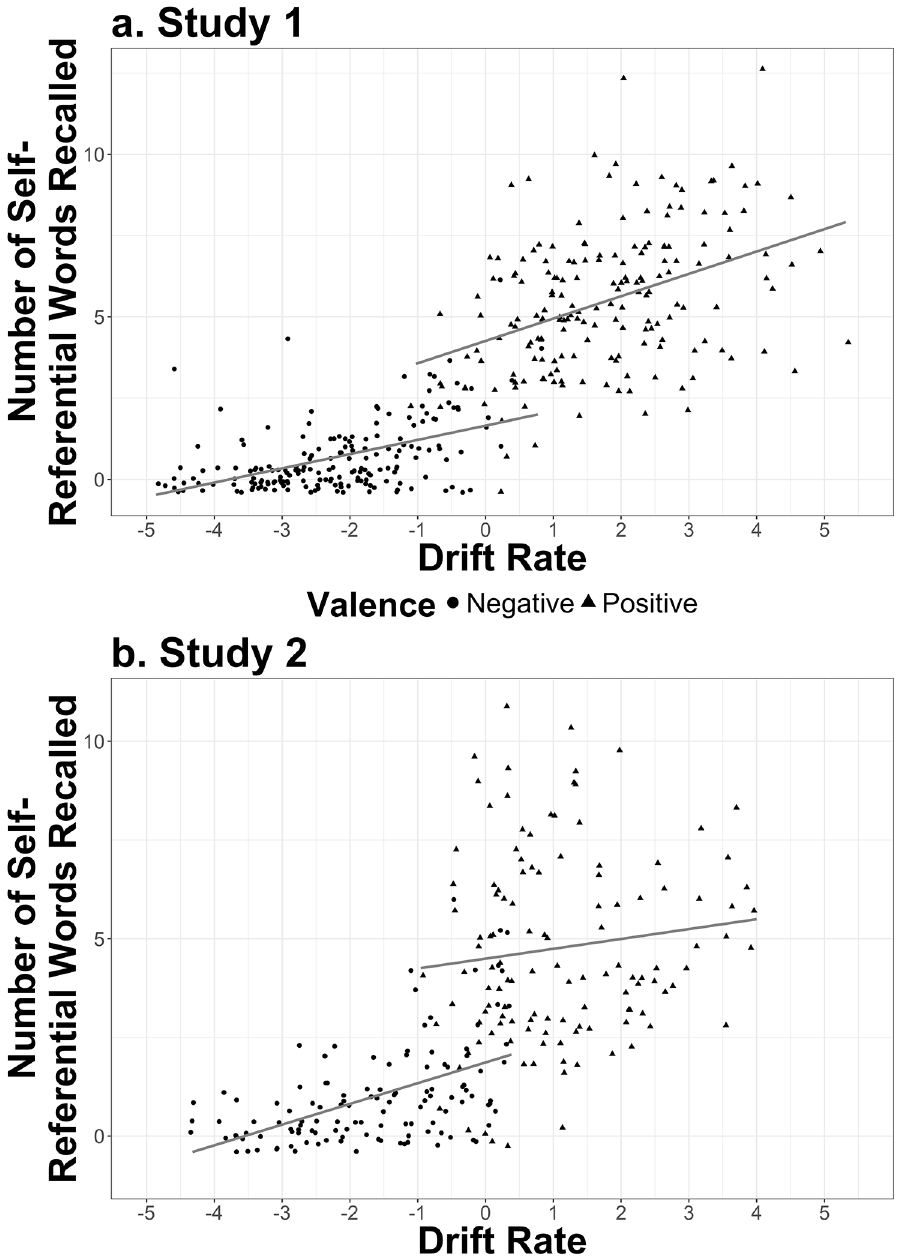
Fig 3. Association between drift rate and recall for self-referential words on the self-referent encoding task. The top plot (a) shows data from Study 1; the bottom plot (b) shows data from the replication, Study 2. The scatterplot shows the relationship between drift rate and recall of positive (circles) and negative (triangles)